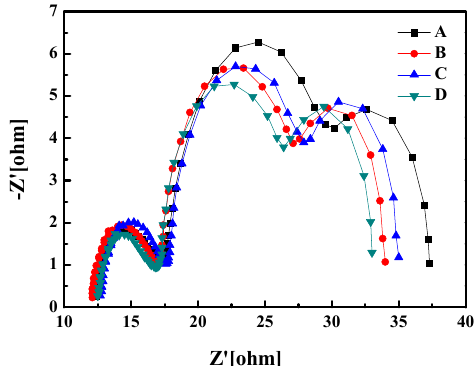
Figure 4. Nyquist plots of the DSSCs. Curves from A to D represent the impedance of bare glass ( sample A ), PDMS/glass ( sample B ), flat PMMA/PDMS/glass ( sample C ) and subwavelength moth-eye structured PMMA/PDMS/glass ( sample D ), respectively.